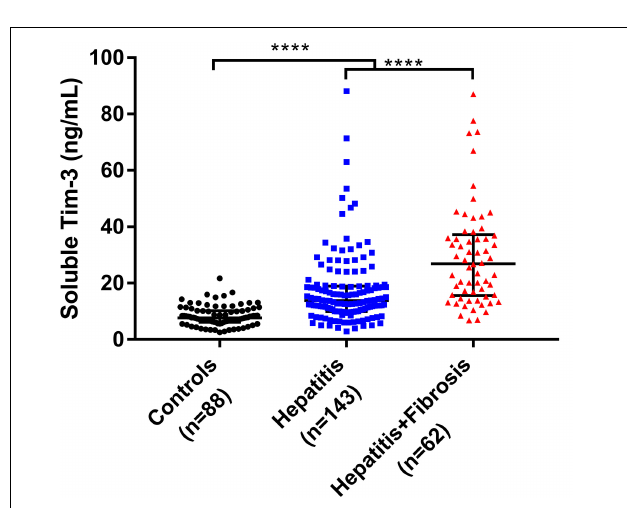
FIGURE 3 | Levels of sTim-3 in normal individuals, patients with hepatitis, and patients with hepatitis and fibrosis. **** P < 0.0001.